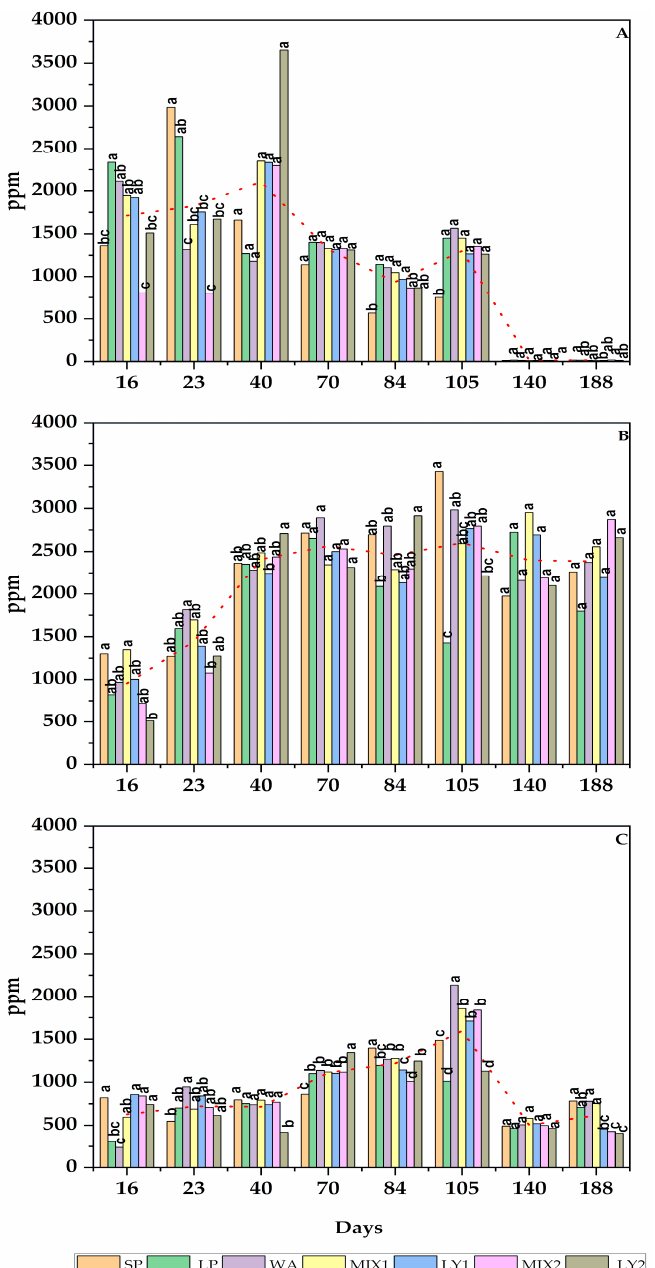
Figure 6. Polyphenol compound concentrations, oleuropein aglycone ( A ), hydroxytyrosol ( B ) and tyrosol ( C ) in the brines during fermentation. The data are expressed as averages of the triplicate measurements. Significant differences (LSD) are indicated by different letters ( p ≤ 0.05). The red dotted line represents the average of a single molecule for each sampling time.